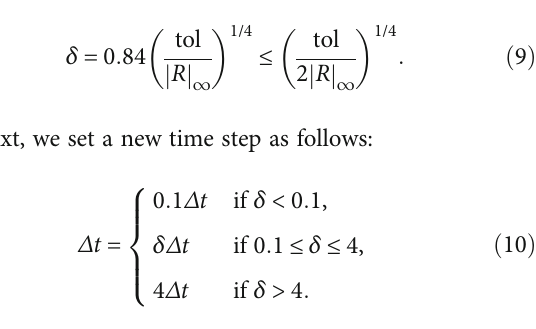
Figure 3: (a – d) Snapshots of the temporal evolution of an initially square shape with ϵ = t = 0 , 0 : 2 , 0 : 3 , and 0 : 5 ,